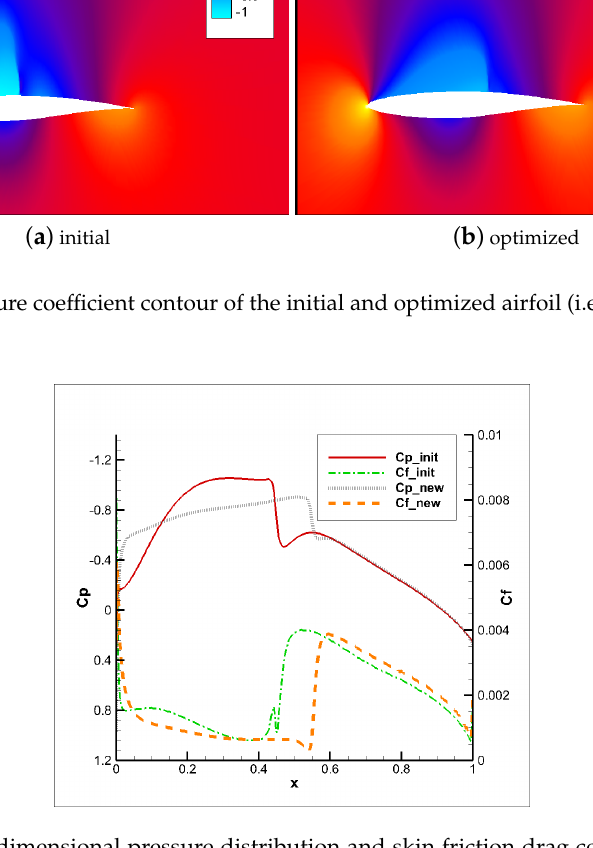
Figure 11. The two-dimensional pressure distribution and skin friction drag coefficient plot of the initial and optimized airfoil (i.e., candidate no. 5 in Figure